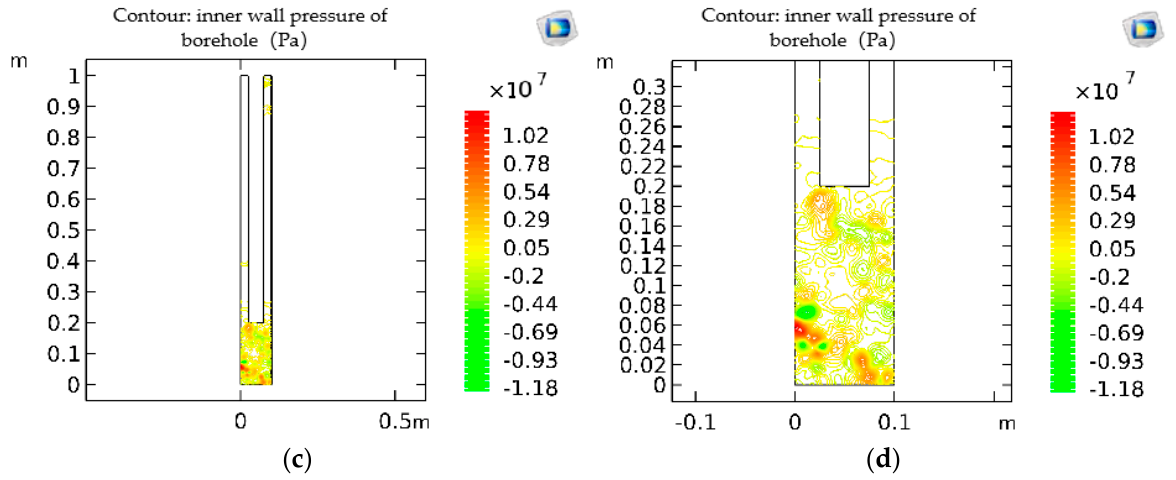
Figure 4. Fluid–solid coupling boundary state of 0.10 m borehole. ( a ) Surface velocity of inner wall of 0.10 m borehole. ( b ) Surface velocity of inner wall of 0.10 m borehole (velocity peak position). ( c ) Hole wall pressure of 0.10 m hole diameter. ( d ) Hole wall pressure of 0.10 m hole diameter (stress peak position).